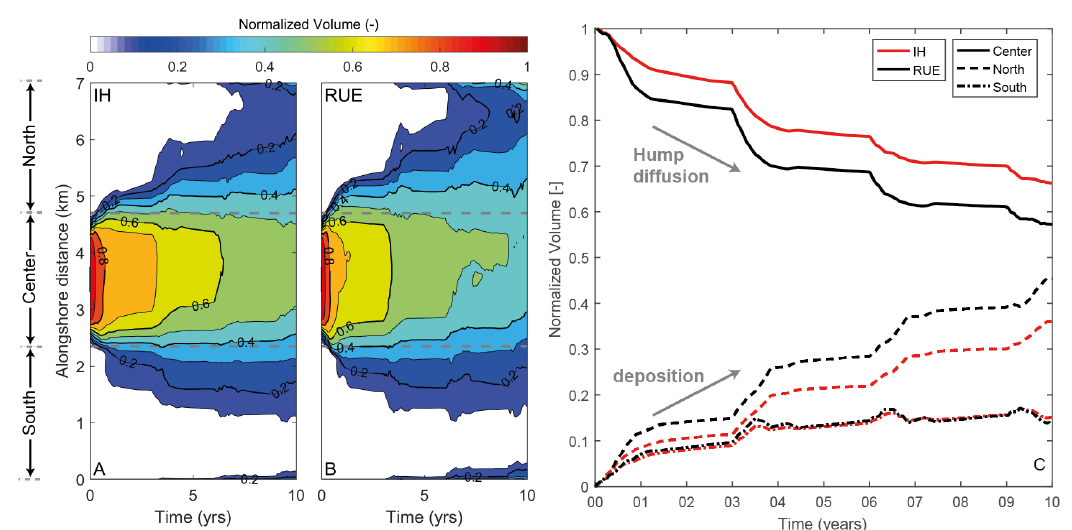
Figure 9. Volumetric diffusion of the coastal hump along the coast within 10 years. ( A , B ) Alongshore evolution of the normalized hump volume through time. ( C ) Normalized volume per zone, where Center is on the hump (indicated by dashed lines in a,b and also in Figure 1C) and North and South are the adjacent areas from the hump. The temporal variability is due to the order of wave conditions.